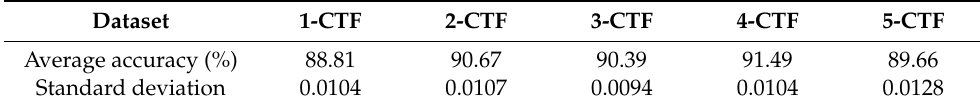
Table 3. Average test accuracy of different